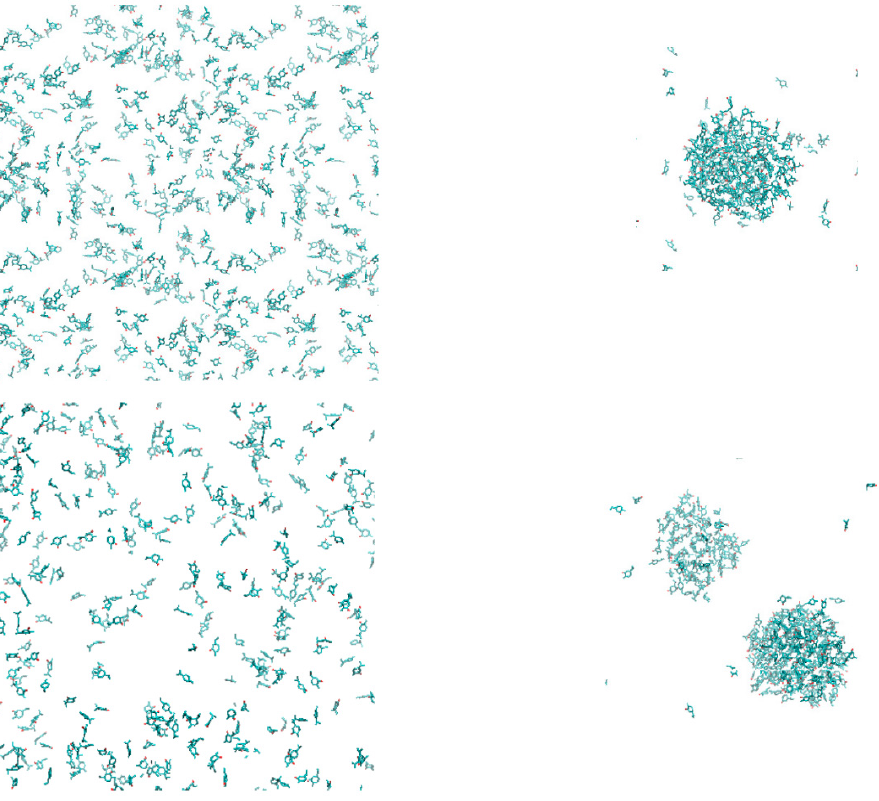
Figure 2. Aquatic solution of carvacrol 0.65 mol/L in its initial state (left, top) and after 6.5 ns (right, top); similar results for the terpenoid mixture in realistic proportions (0.236 mol/L carvacrol, 0.023 mol/L p-cymene, 0.019 mol/L γ -terpinene, 0.009 mol/l thymol) after 15 ns (bottom figures). Water molecules are omitted for clarity.